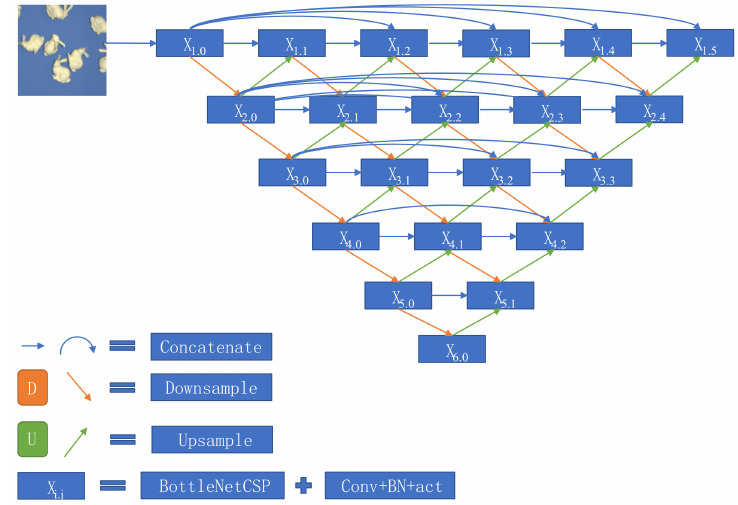
Figure 4. Structure diagram of dense UNet network. The semantic gap between shallow feature coding and deep feature decoding can be reduced, and the segmentation accuracy can be improved by adding a step-by-step skip layer